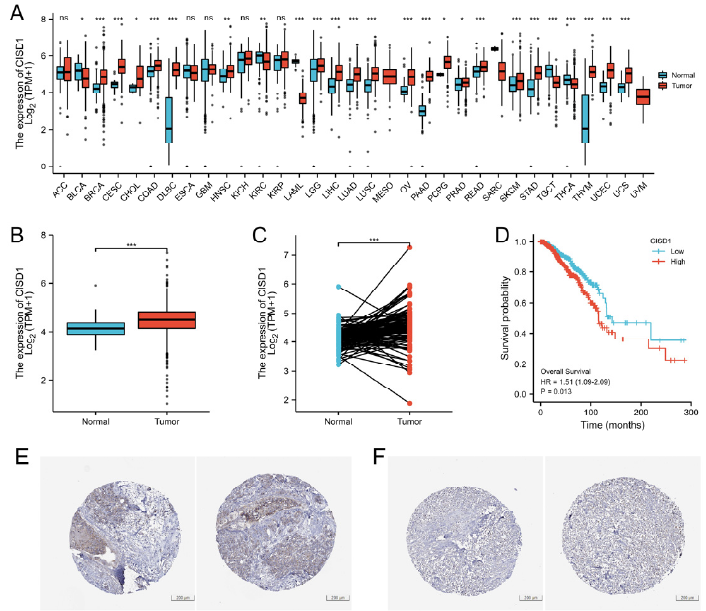
Figure 1. CISD1 expression correlated with life span. CISD1 expression varied in different cancers. ( A ) CISD1 expression level in non-paired; and ( B ) paired breast cancer samples; ( C ) Association between Overall Survival and CISD1 expression; ( D ) Verification of high-level; and ( E ) low-level; ( F ) expression of CISD1 in Human Protein Atlas. “ns”, “*”, “**”, and “***” represented no significance, p -values < 0.05, 0.01, and 0.001, respectively.